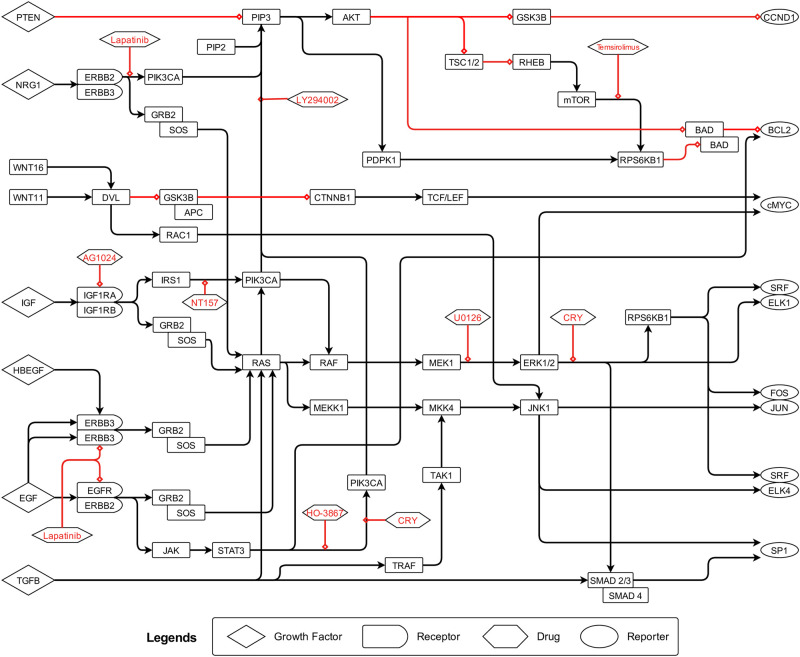
Colorectal cancer pathway.We constructed this pathway of gene regulatory network of CRC using literature. A black arrow denotes activation and a red arrow denotes inhibition. The legends explain the role of different bounding boxes.